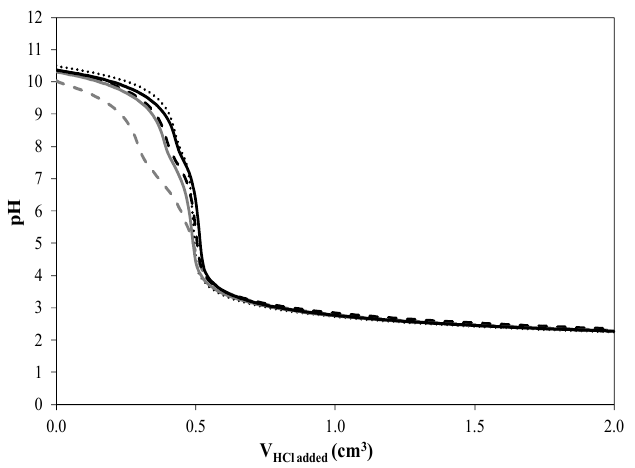
Figure 7. Acid/base titration measurements: Reference; CoN/SiC; CoA/SiC; CoCl/SiC; and CoCit/SiC.